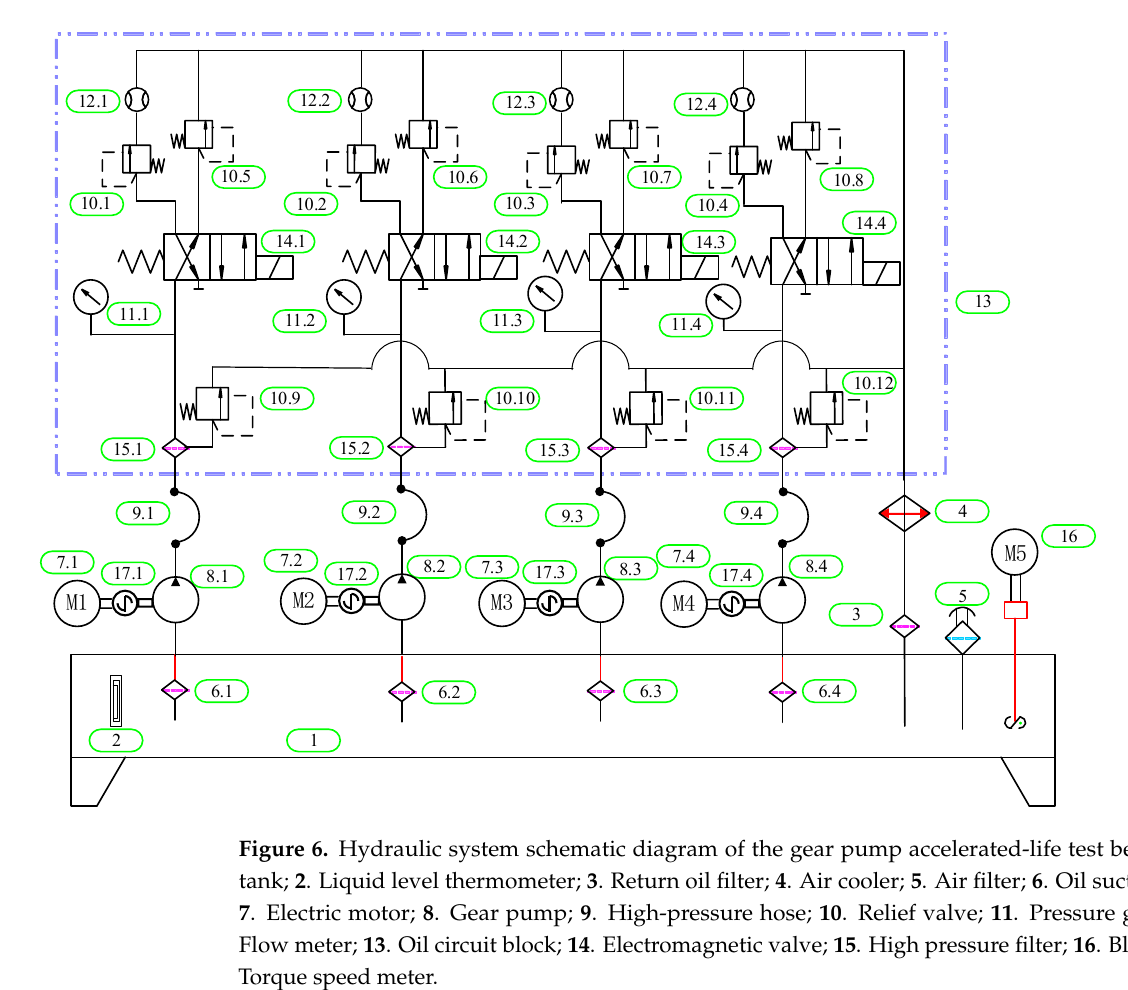
Figure 6. Hydraulic system schematic diagram of the gear pump accelerated-life test bed: 1 . Oil tank; 2 . Liquid level thermometer; 3 . Return oil filter; 4 . Air cooler; 5 . Air filter; 6 . Oil suction filter; 7 . Electric motor; 8 . Gear pump; 9 . High-pressure hose; 10 . Relief valve; 11 . Pressure gauge; 12 . Flow meter; 13 . Oil circuit block; 14 . Electromagnetic valve; 15 . High pressure filter; 16 . Blender; 17 . Torque speed meter. The vibration of the hydraulic pump includes not only the meshing vibration of the gear but also the mutual coupling of hydraulic shock vibration. The gear meshing vibra- tion and hydraulic shock vibration are transmitted to the vibration sensor through the pump body. During the test, four gear pumps of the same model were operated at the same time, and acceleration sensors were installed in three directions ( x , y , and z ) of the end cover of each gear pump, as shown in Figure 7. The main component models and performance parameters used in the test bed are shown in Table 3.